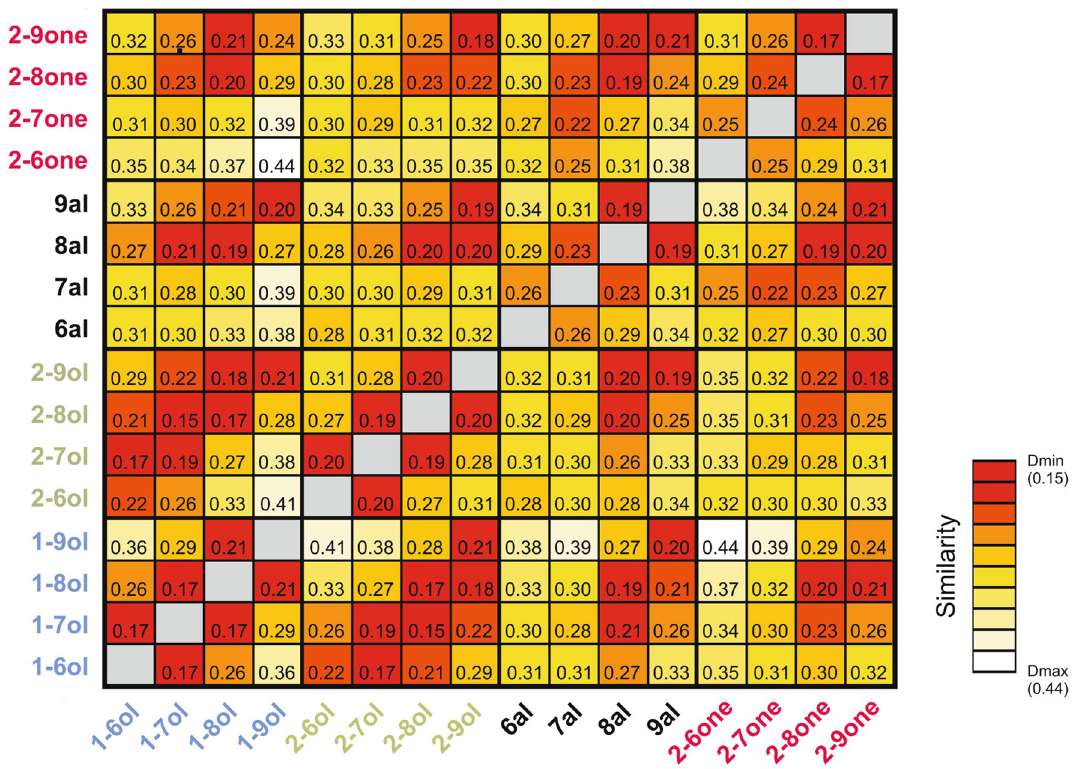
similarity (longer distances, D max ) is shown in lighter colors (white and yellow). The matrix shows generally higher similarity (smaller distances) among odorants with a long carbon chain length (C8 and C9, e.g. 8al vs. 2-9one or 9al vs. 1-8ol) compared to the corresponding odor pair combinations within shorter chain lengths, i.e. C6 and C7. High similarity is also observed between primary and secondary alcohols, along a diagonal line showing a dependency on chain length (lower left side of the